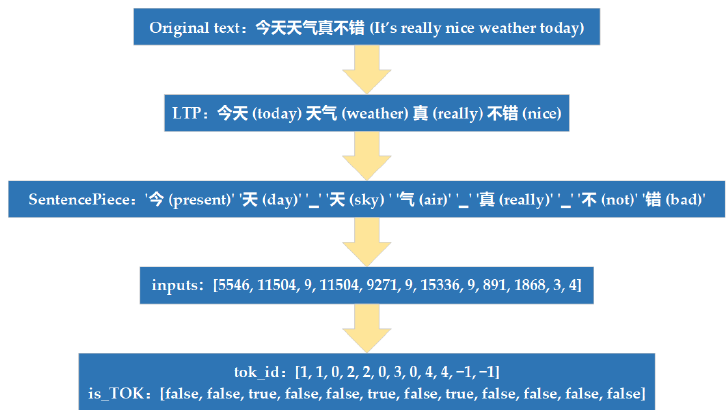
Figure 8. Generation of vector tok_id and is_TOK.